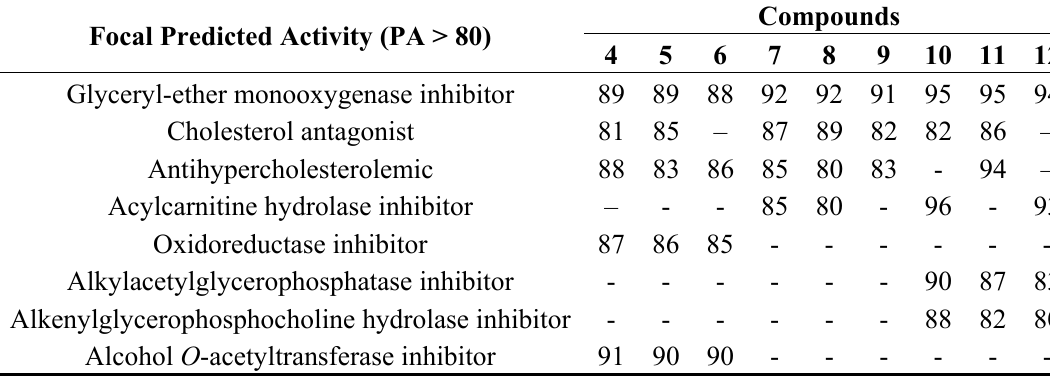
Table 3. PA (Probability “to be Active”) values for predicted biological activity of compounds 4 – 12